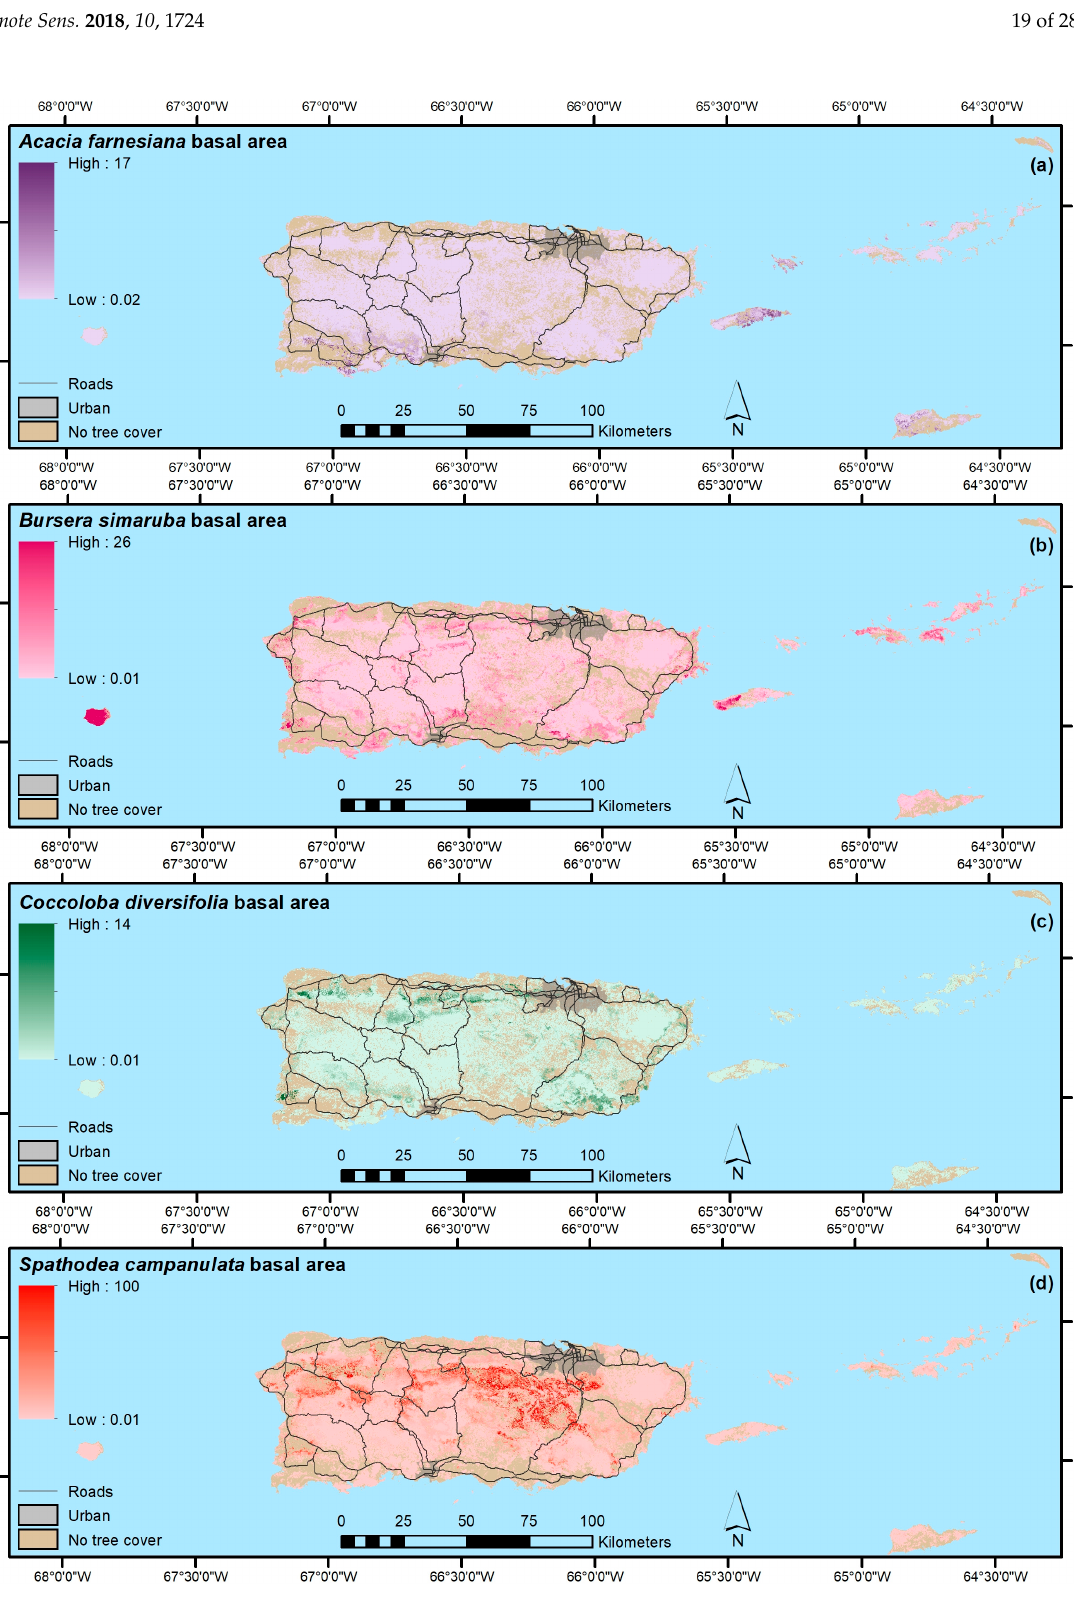
Figure 9. Basal areas in m 2 /ha of four species as mapped with PGNN modeling, including ( a ) an introduced species found in young or frequently disturbed dry forests; ( b ) a common native species found in dry and edaphically dry places; ( c ) a native species typical of humid karst areas; and ( c ) the most common species in Puerto Rico, which is an introduced species.